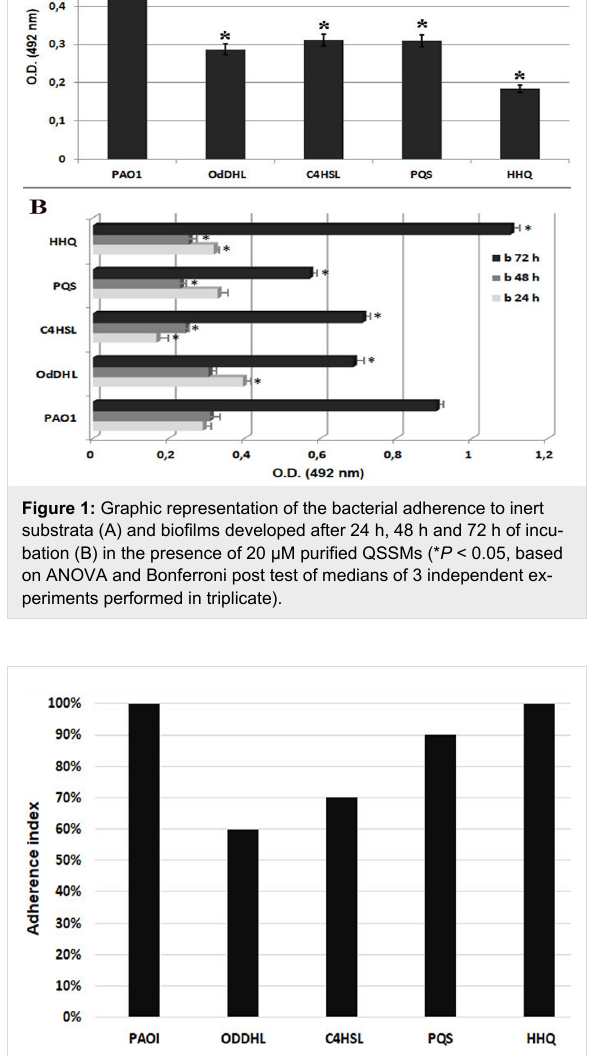
to the endothelial cells was registered, from aggregative (control PAO1) to diffuse aggregative. As seen in Table